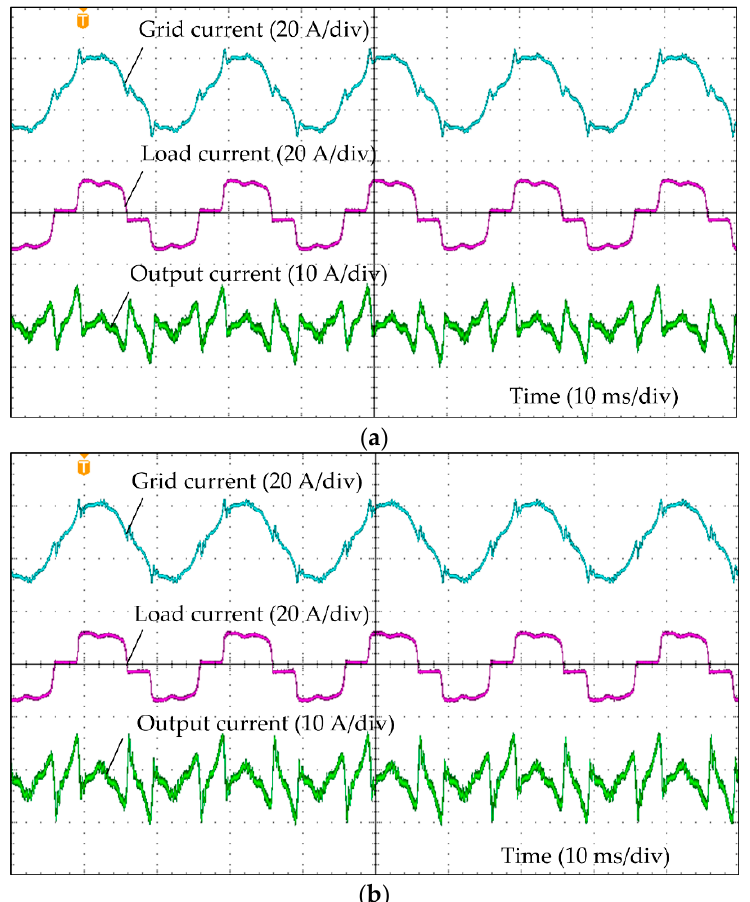
Figure 14. Experimental result. ( a ) Without reference compensation; ( b ) with reference compensation.